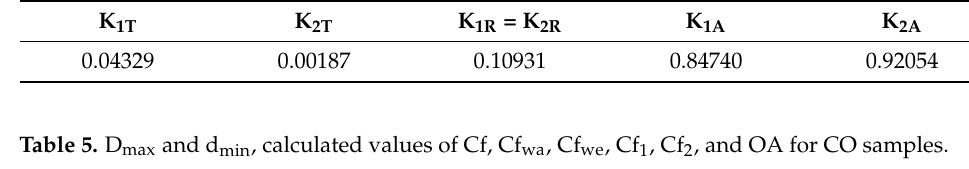
Table 4. Calculated values of K T , K R , and K A for CO samples.